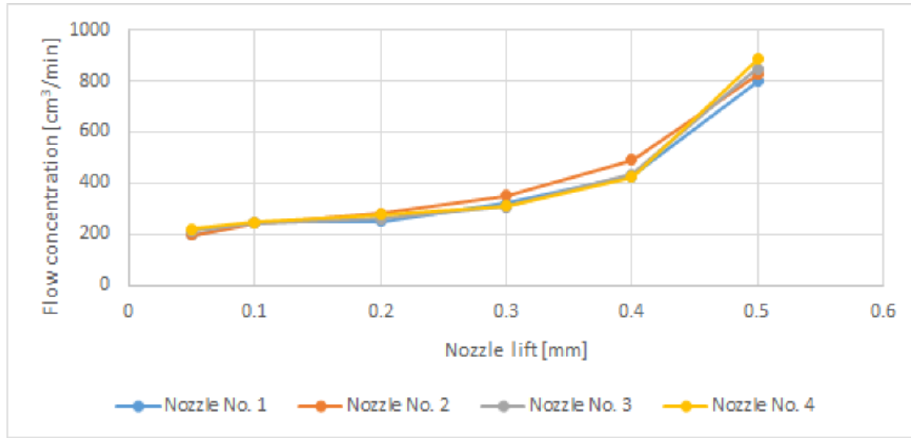
Figure 5. The flow before the test for